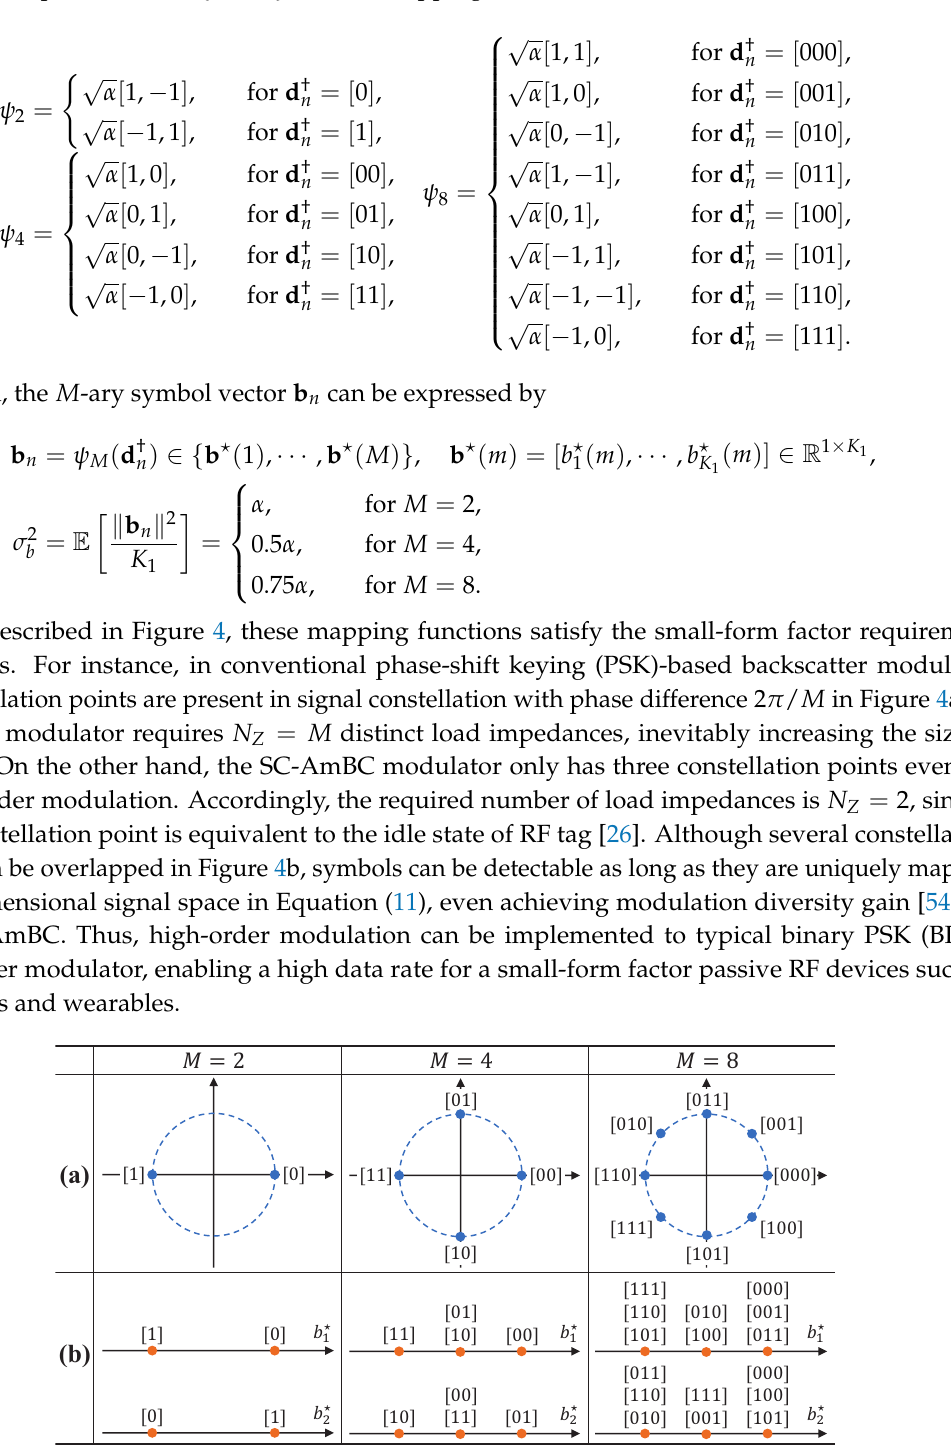
Figure 4. Example of mapping function ψ M for AmBC. ( a ) PSK-based backscatter modulator; ( b ) sparse-coded backscatter